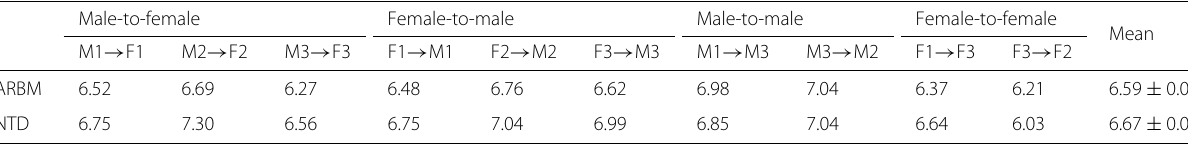
Table 3 Average MCD [dB] using non-parallel data Male-to-female Female-to-male Male-to-male